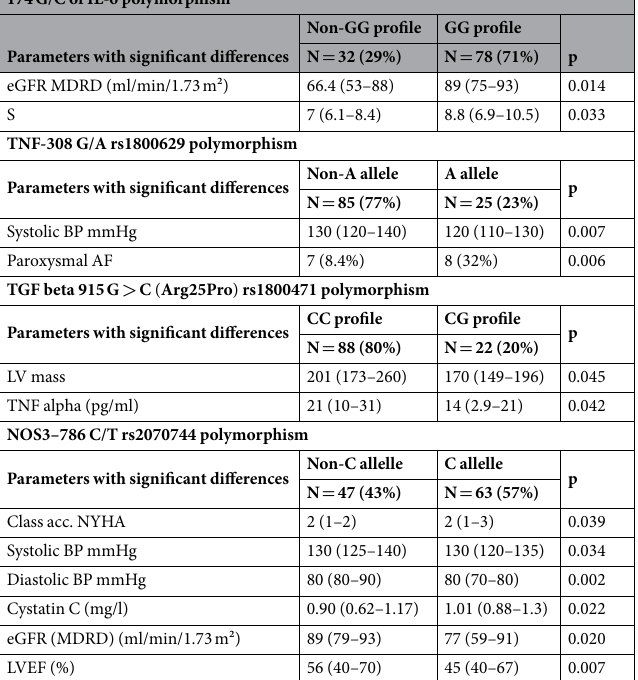
Table 3. The significant differences in selected polymorphisms. Presented values: median (Q25-Q75). ABBREVIATIONS: eGFR MDRD, estimated glomerular filtration rate on the basis of the study Modification of Diet in Renal Disease; S’, systolic mitral annular velocity; BP, blood pressure; AF, atrial fibrillation; LV, left ventricular; TNF, tumor necrosis factor; NYHA, New York Heart Association; LVEF, left ventricular ejection fraction.